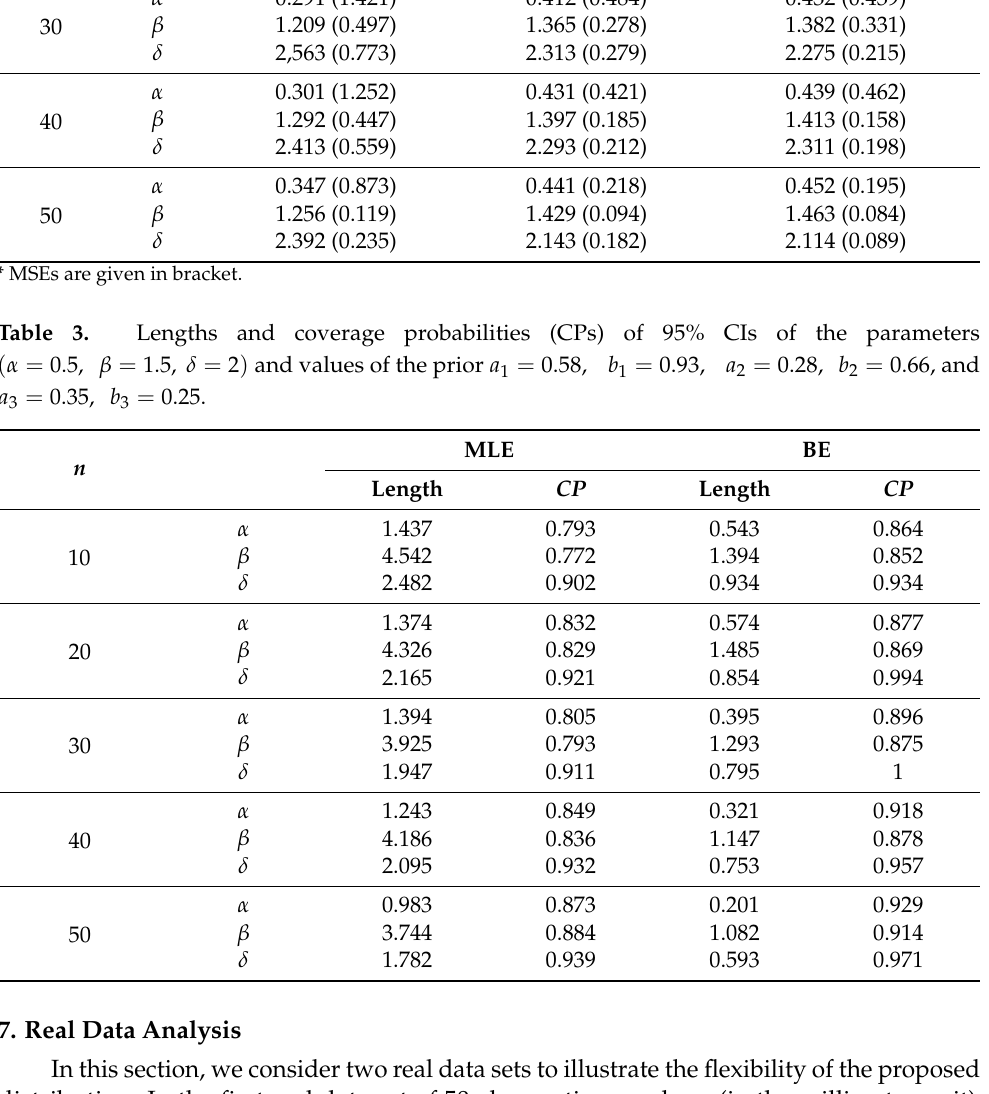
Table 2. MLE, BE and with their * MSEs for the parameters ( α = 0.5, β = 1.5, δ = 2 ) and values of the prior a 1 = 0.58, b 1 = 0.93, a 2 = 0.28, b 2 = 0.66 and a 3 = 0.35, b 3 = 0.25.